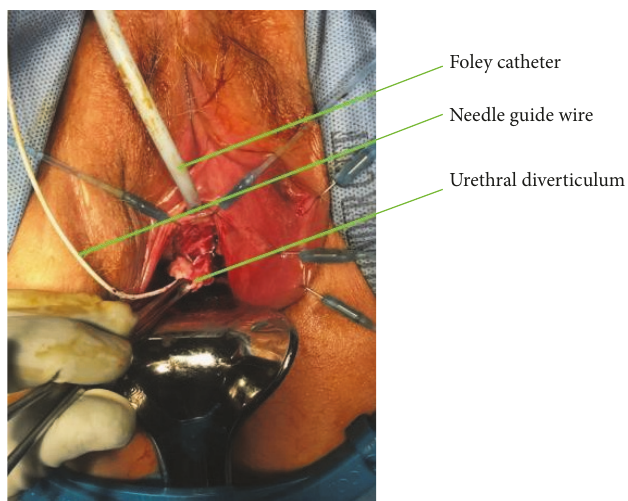
Figure 3: Urethral diverticulum isolated with needle localization.